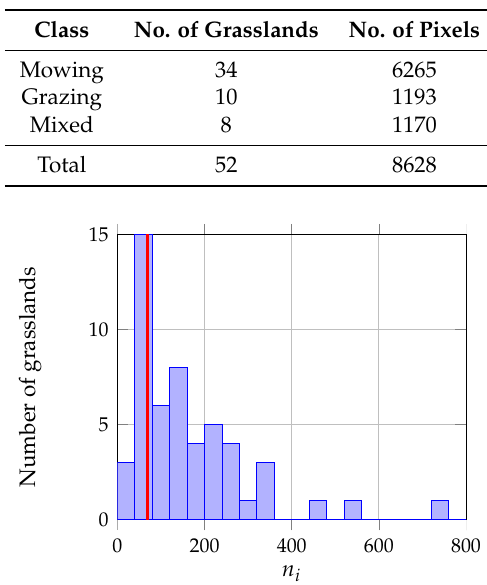
Table 2. Grassland management types and composition of the dataset.